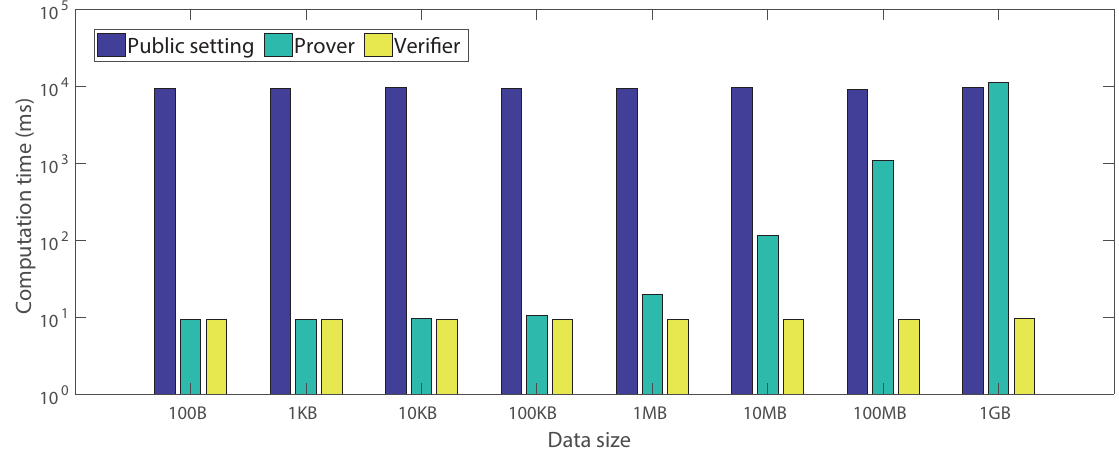
Figure 7. Computation time for Merkle tree-based authentication with encrypted communication.